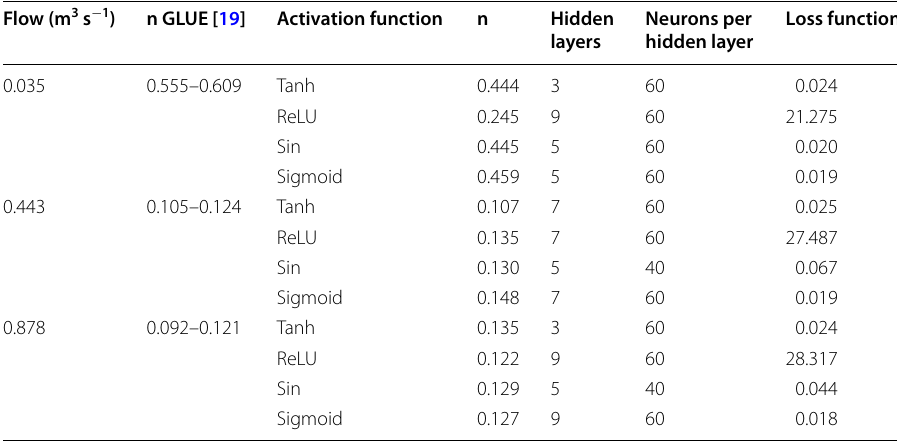
Table 2 Inverse PINN comparison between calibrated roughness values from GLUE experiments and the ones obtained from different AFs and different flow